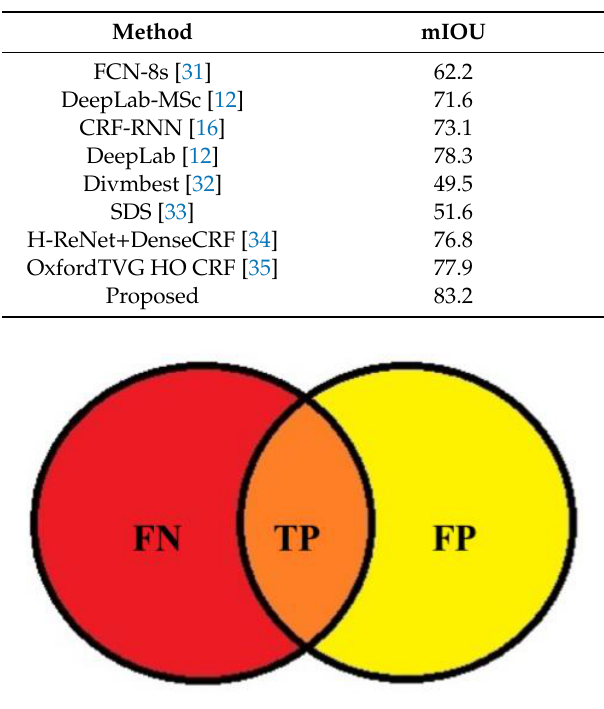
Figure 12. Depiction of the mean-intersection-over-union (mIOU).